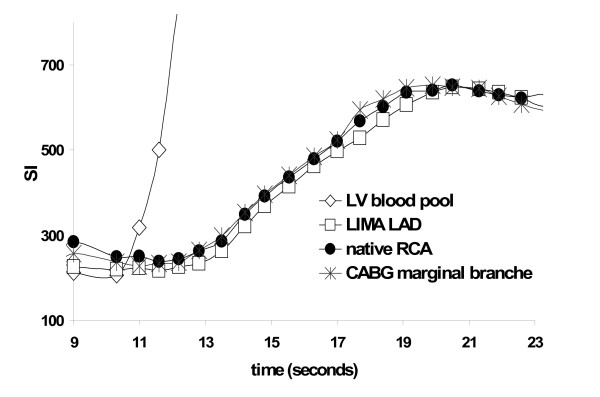
Example of signal intensity time curve during adenosine vasodilatation of a native RCA, LIMA LAD and venous CABG to a marginal branch in one patient.